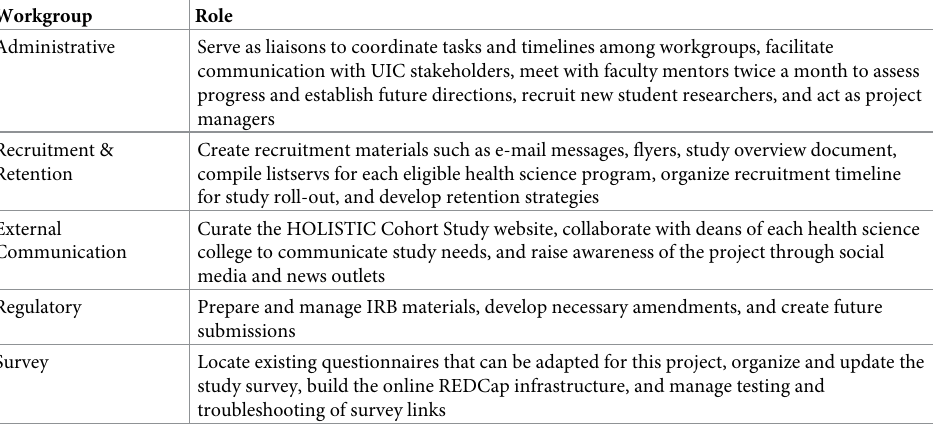
Table 1. Organization of the HOLISTIC Cohort Study research